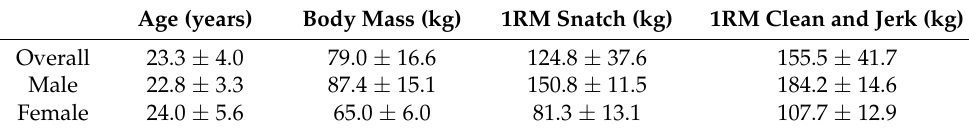
Table 1. Descriptive data in means and standard deviations of the study